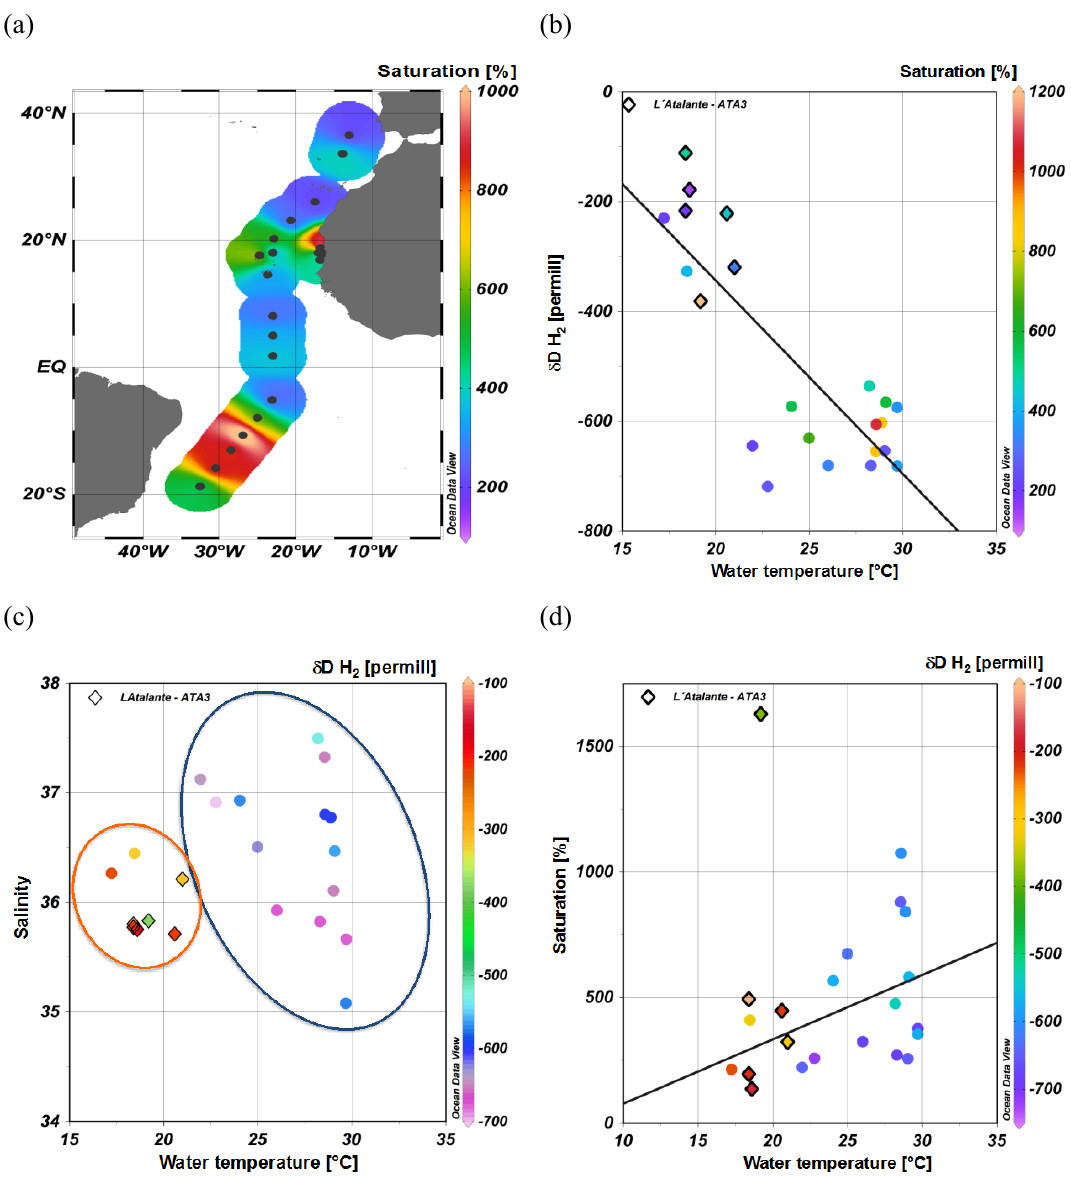
Figure 7. (a) H 2 saturation in the surface water (color coded) along the RV Polarstern cruise track of ANT-XXVI/4 and the RV L’Atalante cruise ATA-3, with maxima around the Cape Verde islands and 10–15 ◦ S, Note: each sample is represented by a single dot. (b) Comparing the δ D (H 2 ) at different water temperatures, the respective H 2 saturation are color coded, sample dots marked with a diamond belong to the RV L’Atalante cruise, sample dots without to the ANT-XXVI/4 cruise; y = − 35 . 2 x + 360 . 9, R 2 = 0.66, n = 22. (c) Distribution of δ D (H 2 ) (color coded) in correlation between water temperature and salinity. (d) Correlation between water temperature and H 2 saturation, the δ D (H 2 ) is color-coded, the exceptional high saturation has been excluded from the correlation calculation, y = 0 . 26 x − 2 . 79, R 2 = 0.22, n =